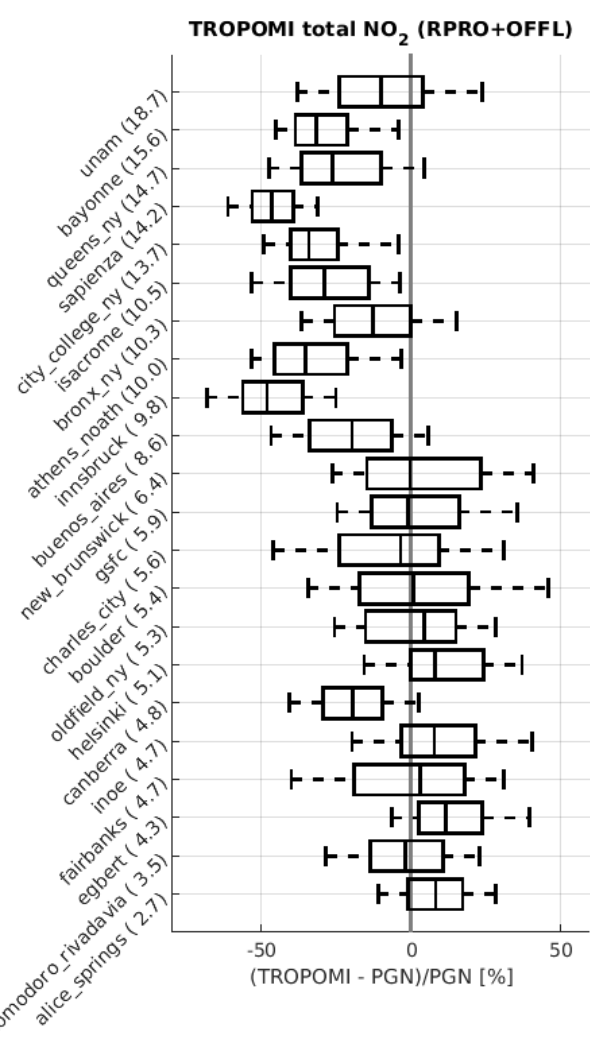
Figure 14. Same as Figs. 6 and 10 but now for the difference between S5P TROPOMI (RPRO + OFFL) and PGN NO 2 total columns. Stations are ordered by ground-based total NO 2 median value, like in Fig. 10. The median difference is represented by a ver- tical solid line inside the box, which marks the 25% and 75% quan- tiles. The whiskers cover the 9%–91% range of the differences. The three mountaintop PGN instruments used for the validation of the stratospheric columns are not included here but in Fig.